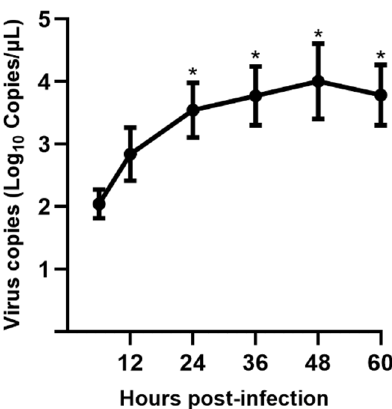
Figure 3. PDCoV CHN-SC2015 replication kinetics in LLC-PK cells was determined by qRT-PCR. The total viral RNA from PDCoV CHN-SC2015 infected LLC-PK cells at different times (12 h, 24 h, 36 h, 48 h and 60 h) was extracted and subjected to qRT-PCR. The quantity of PDCoV viral RNA was calculated based on the standard curve and is expressed as the copies per milliliter of the cell culture. * indicates that the significant difference compared to 6 h post-infection.